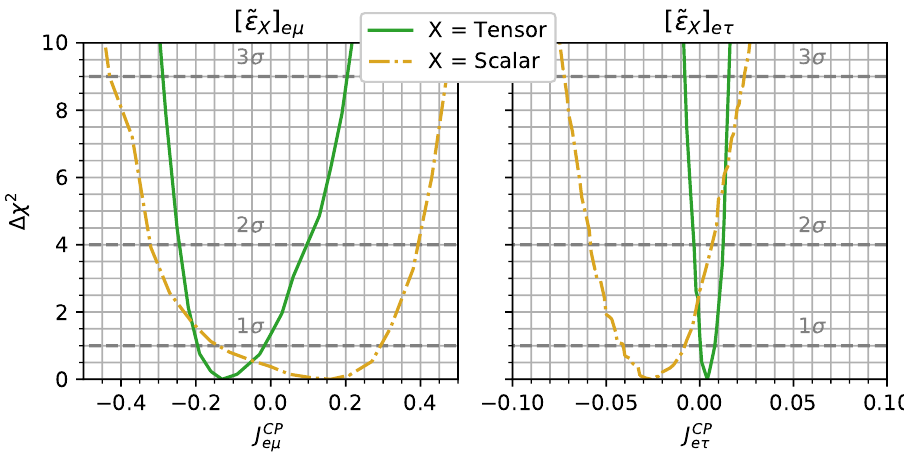
Figure 5 . In this figure we show the ∆ χ 2 as a function of the CP-violation parameters, in the left (right) panel we show the J ( J ) parameters of eqs. (2.26) and eτ eµ